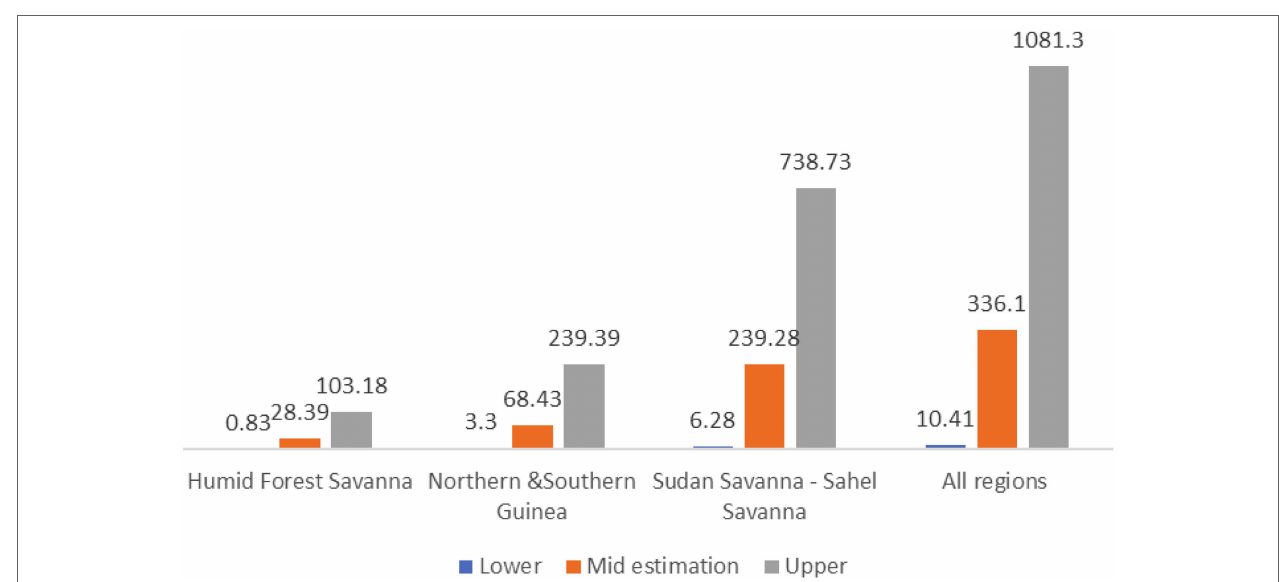
FIGURE 2 | PBR cowpea in Nigeria: Net Present Benefits (NPV) over a 25-year period if PBR cowpea is planted in 2020 (million US$; Phillip et al., 2019). Estimations were done in local currency units, converted to US dollars using the official annual exchange rate for 2016, the base year used for these